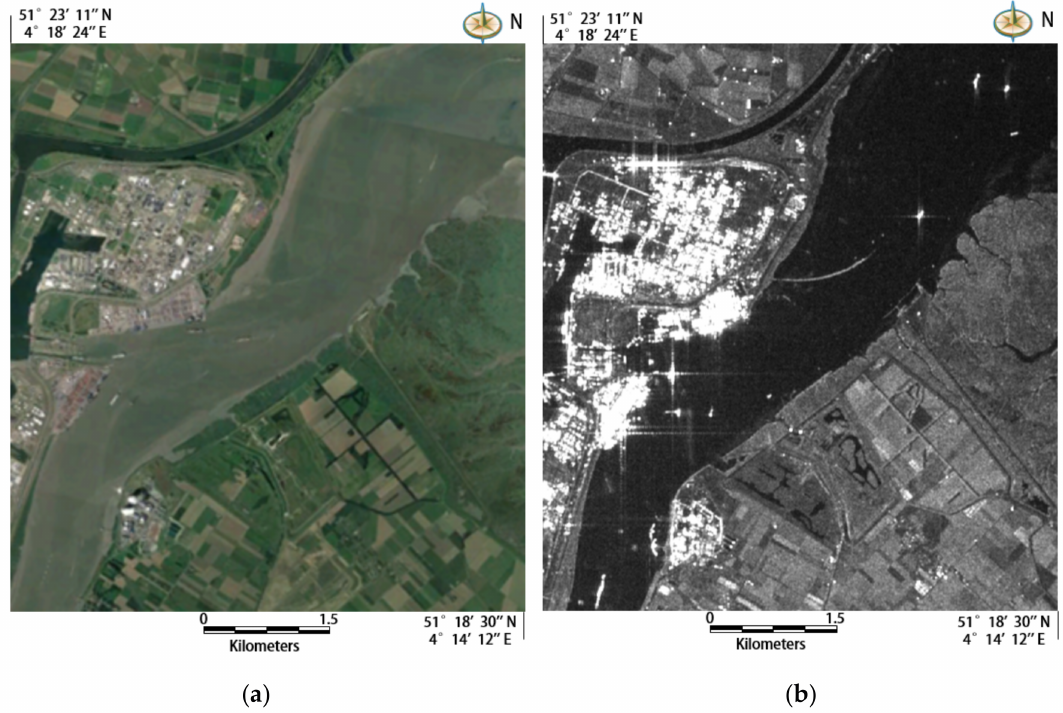
Figure 6. The study area and Sentinel-1 SAR dataset with C band. ( a ) Optical image from Google Earth; ( b ) HH polarization SAR image with C